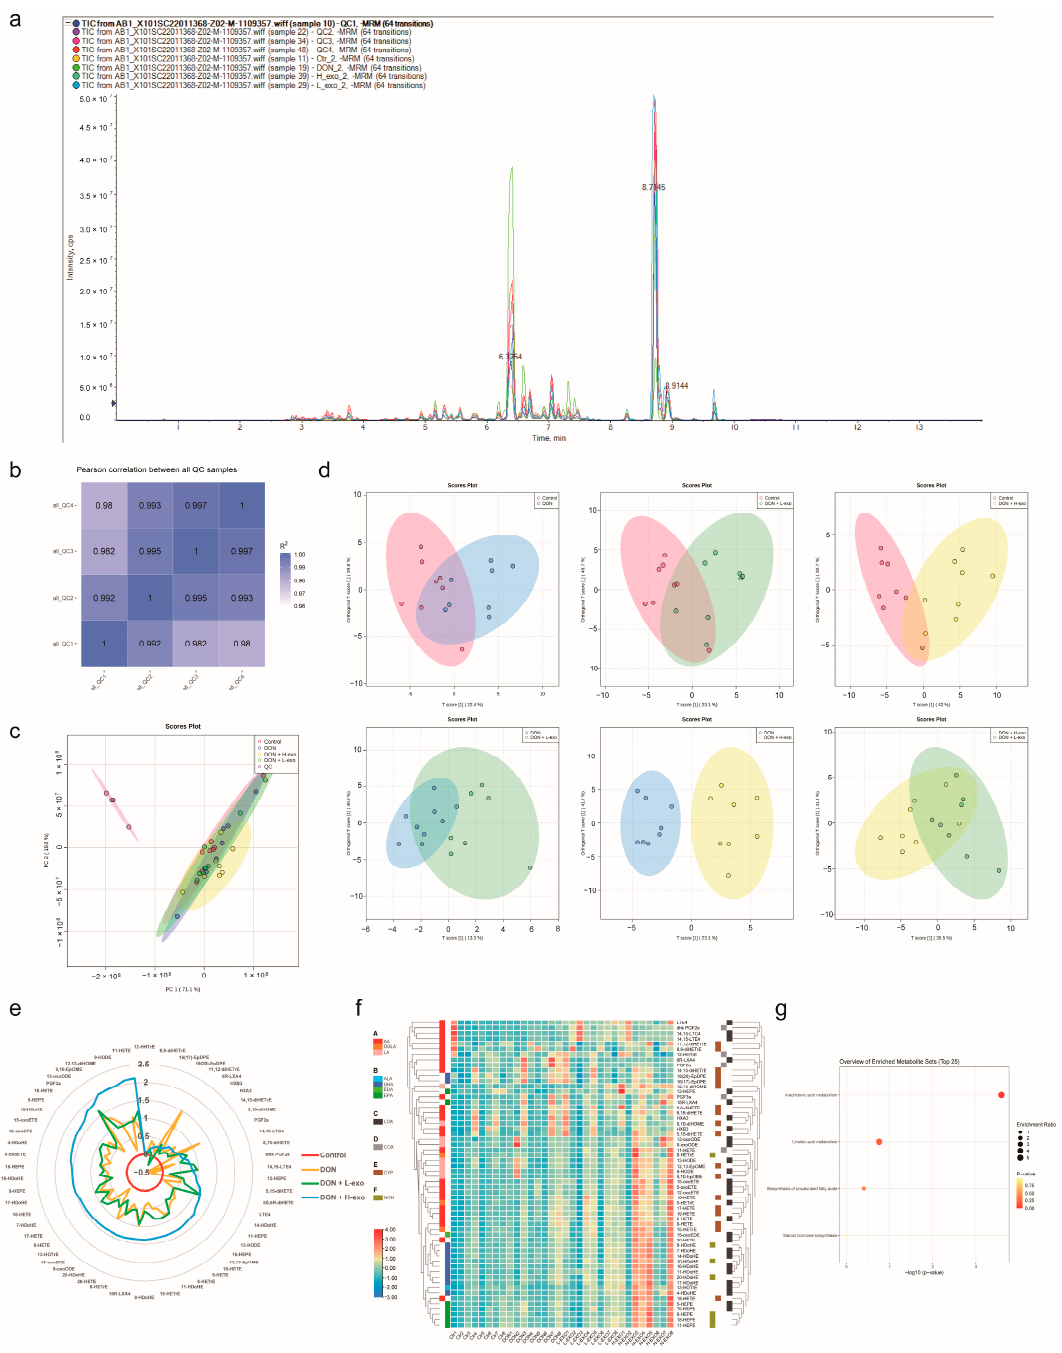
Figure 5. Oxidized lipidome of the liver. ( a ) Total ion chromatogram (TIC) of oxidized lipid profile in the liver. ( b ) Correlation between QC samples. ( c ) PCA analysis of all samples, including QCs. ( d ) Orthogonal partial least squares discriminant analysis (orthoPLS-DA) of the relative oxylipins content in mouse liver between different groups. ( e ) Radar plot showing oxylipin distribution patterns, with data expressed as log(2) FC over control. ( f ) Hierarchical clustering analysis of the relative abundance distribution heat map of oxylipins in four groups of mice according to the precursor source of oxidized lipid and the oxidation reaction pathway. ( g ) Pathway enrichment analysis of the oxidized lipidome. All matched pathways are plotted according to the p -value from pathway enrichment analysis and pathway impact values from pathway topology analysis. The color gradient and circle size indicate the significance of the pathway ranked by p -value (yellow, higher p values; red, lower p values) and pathway impact values (the larger the circle, the higher the impact